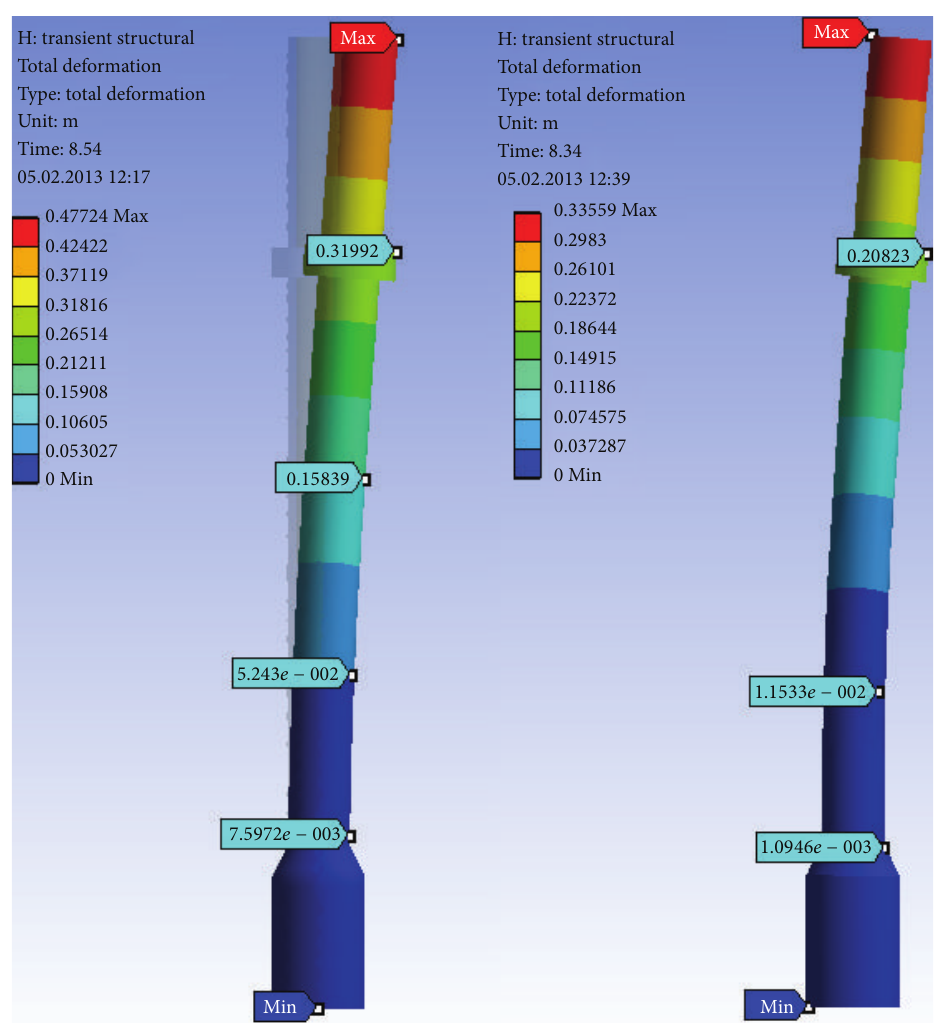
Figure 12: Maximum lateral deformation profiles for scaled Synthetic EQ record (left: bare minaret model; right: strengthened model, in m).